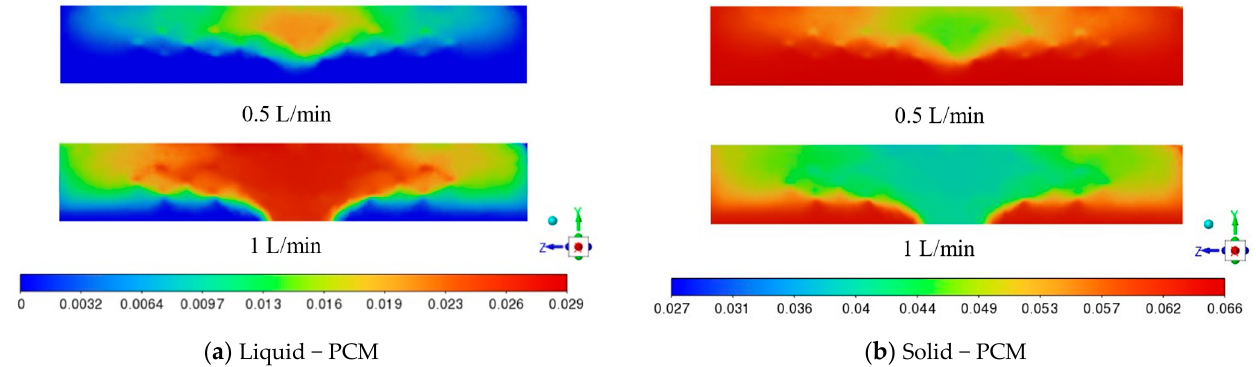
Figure 6. Sectional view (YZ − Plane, X = 0.039 m) of 10 wt% PCM fluid at the Re inlet when the melted PCM is 80 g at the SC outlet.